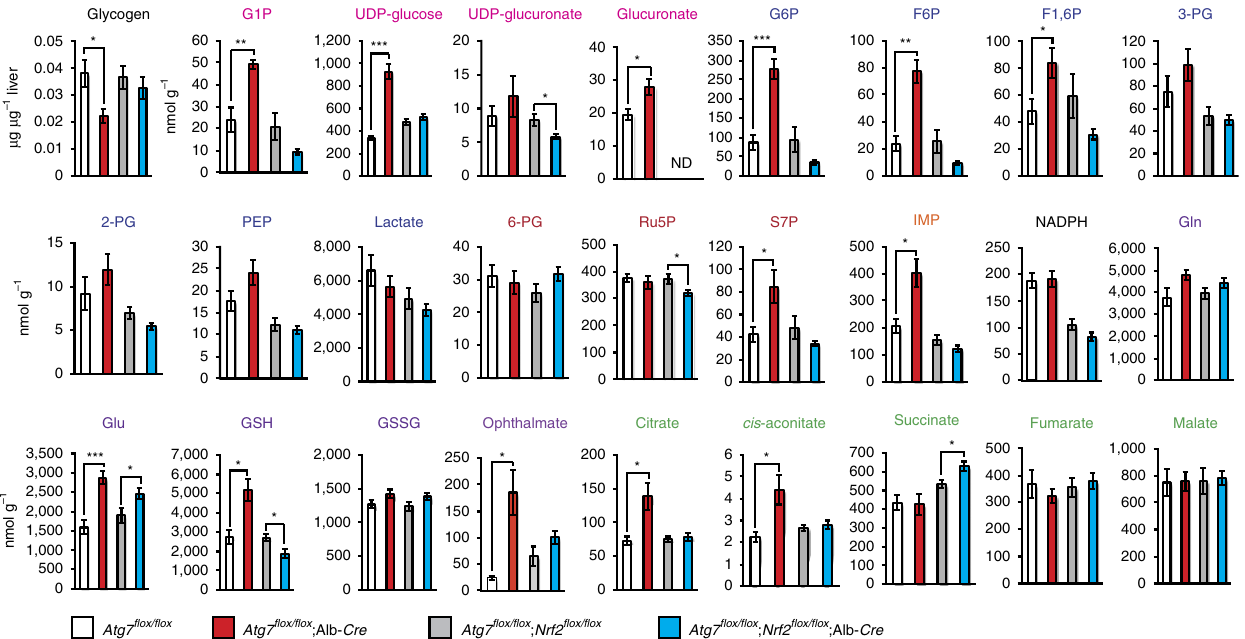
Figure 7 | Metabolic intermediates in autophagy-deficient mouse livers. Quantification of metabolic intermediates in glucose and glutamine metabolism in livers of female Atg7 f/f ( n ¼ 5), Atg7 f/f ;Alb- Cre ( n ¼ 5), Atg7 f/f ; Nrf2 f/f ( n ¼ 10) and Atg7 f/f ; Nrf2 f/f ;Alb- Cre mice ( n ¼ 13) aged at 5 weeks. The amount of glycogen was also quantified. Data are means ± s.e. * P o 0.05, ** P o 0.01 and *** P o 0.001 as determined by the Welch t